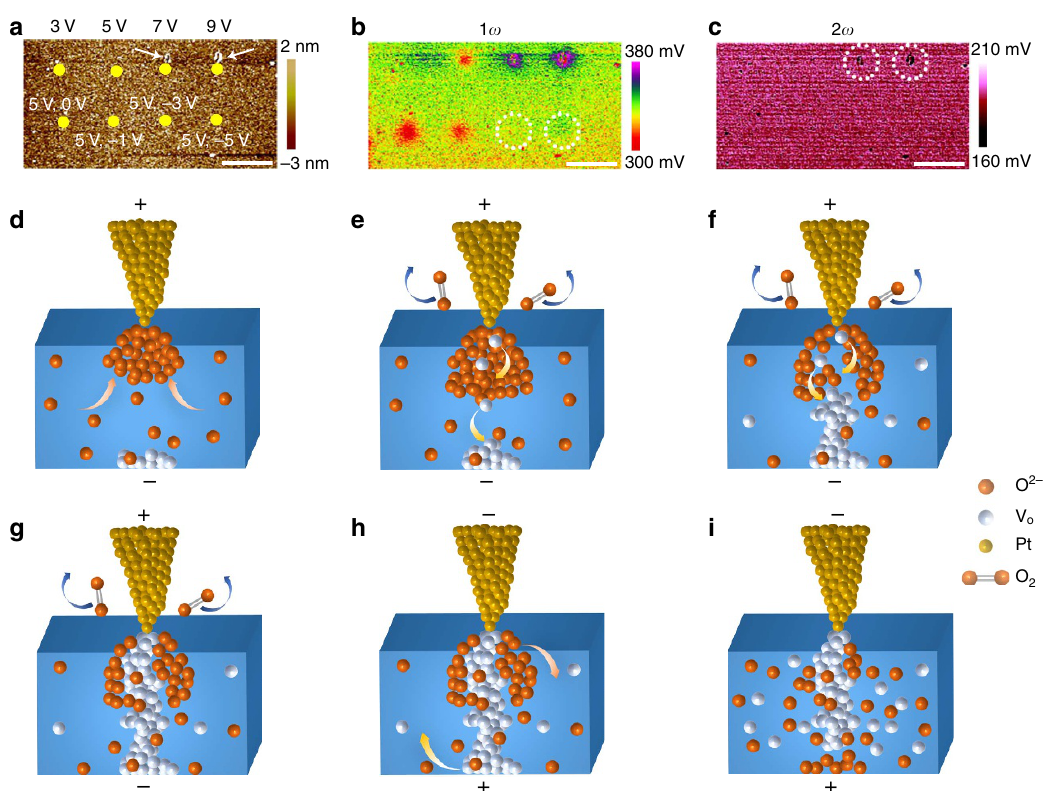
Figure 6 | Reversible oxygen ion dynamics in forming and reset processes. ( a – c ) Topographic ( a ), 1 o ( b ) and 2 o ( c ) measurements on the HfO 2 /TiN sample after positive voltage sweepings to 3, 5, 7 and 9V at different locations in the upper row, along with bidirectional voltage sweepings of (5V, 0V), (5V, (cid:2) 1V), (5V, (cid:2) 3V) and (5V, (cid:2) 5V) in the lower row. Scale bar, 3 m m. ( d – i ) Schematic illustration of dynamic ion motion and filament formation/ dissolution processes during the forming and reset processes of HfO 2 memristors. ( d ) A positive voltage on the Pt tip attracts oxygen ions to the top interface and repels oxygen vacancies to the bottom interface. ( e ) Oxidation of the oxygen ions at the top interface leads to oxygen gas eruption and oxygen vacancies formation. ( f ) The migration of oxygen vacancies to the bottom interface and continued redox reactions lead to gradual growth of the oxygen vacancy filament. ( g ) Formation of an oxygen-deficient filament through the HfO 2 film. The device is switched to on state in this case. ( h ) Reversal of applied voltage will drive oxygen ions away from the top interface and oxygen vacancies away from the bottom interface. ( i ) Continued application of negative voltage on the tip leads to dissolution of the oxygen-deficient filament. The device is switched to off state in this